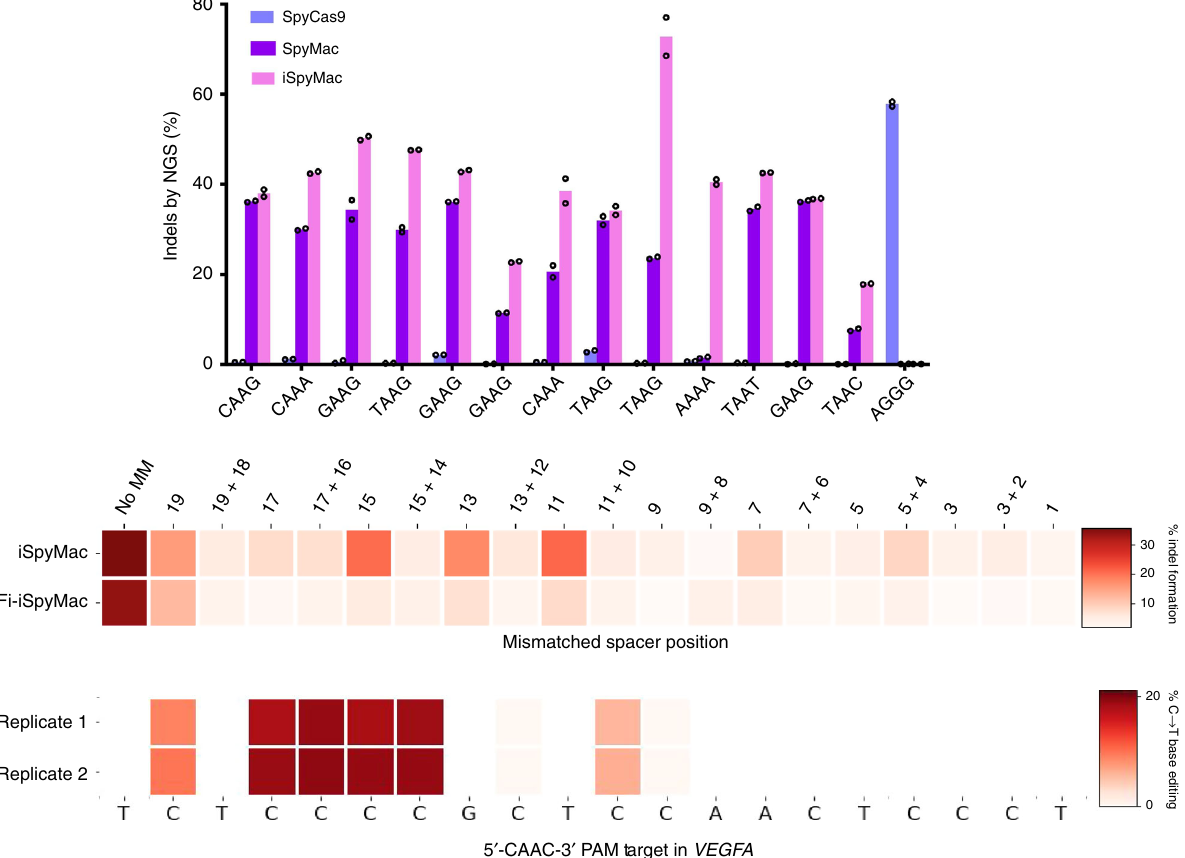
Fig. 3 Genome editing capabilities of engineered SmacCas9 variants. a CRISPResso2 indel analysis following NGS of ampli fi ed genomic regions to assess on-target editing of iSpyMac in comparison to SpyMac and SpyCas9, on the indicated 5 0 -NAA-3 0 and 5 0 -NGG-3 0 PAM sequences. Samples were performed in two independent transfection replicates ( n = 2). b Ef fi ciency heatmap of mismatch tolerance assay on genomic targets. Quanti fi ed indel frequencies, as assessed by the TIDE algorithm 41 , are exhibited for each labeled single or double mismatch in the sgRNA sequence for the indicated Cas9 variant and indicated PAM sequence. Samples were performed in two independent transfection replicates ( n = 2). c CRISPResso2 genomic base editing analysis following NGS of genomic amplicons to assess conversion of cytosines to thymines by iSpyMac-BE3. Samples were performed in two independent transfection replicates ( n = 2). All source data are provided as a Source Data fi